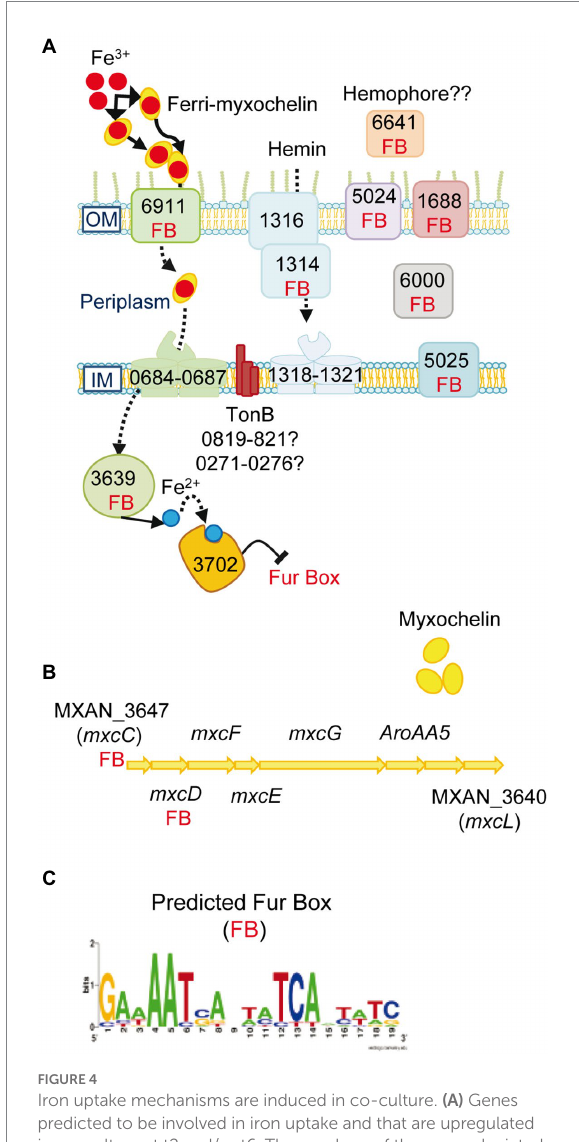
FIGURE 4 Iron uptake mechanisms are induced in co-culture. (A) Genes predicted to be involved in iron uptake and that are upregulated in co-culture at t2 and/or t6. The numbers of the genes depicted in the figure are the corresponding MXAN_ identifiers. (B) Graphical representation of the cluster of genes involved in myxochelin biosynthesis. The seven upregulated transcripts are indicated by their corresponding gene name. (C) Fur box (FB) predicted by using the Virtual Footprint database. Red balls: Fe 3+ ; blue balls: Fe 2+ . OM, outer membrane; IM, inner membrane. For more details please see the text and Supplementary Table